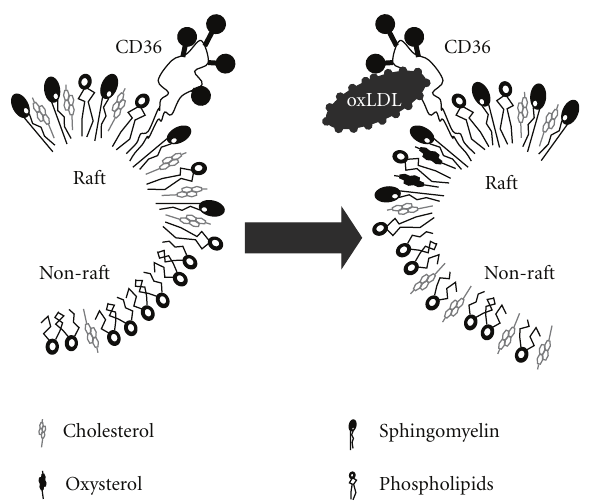
Figure 6: A model proposed for the impact of oxLDL on the lateral distribution of cholesterol between raft and nonraft